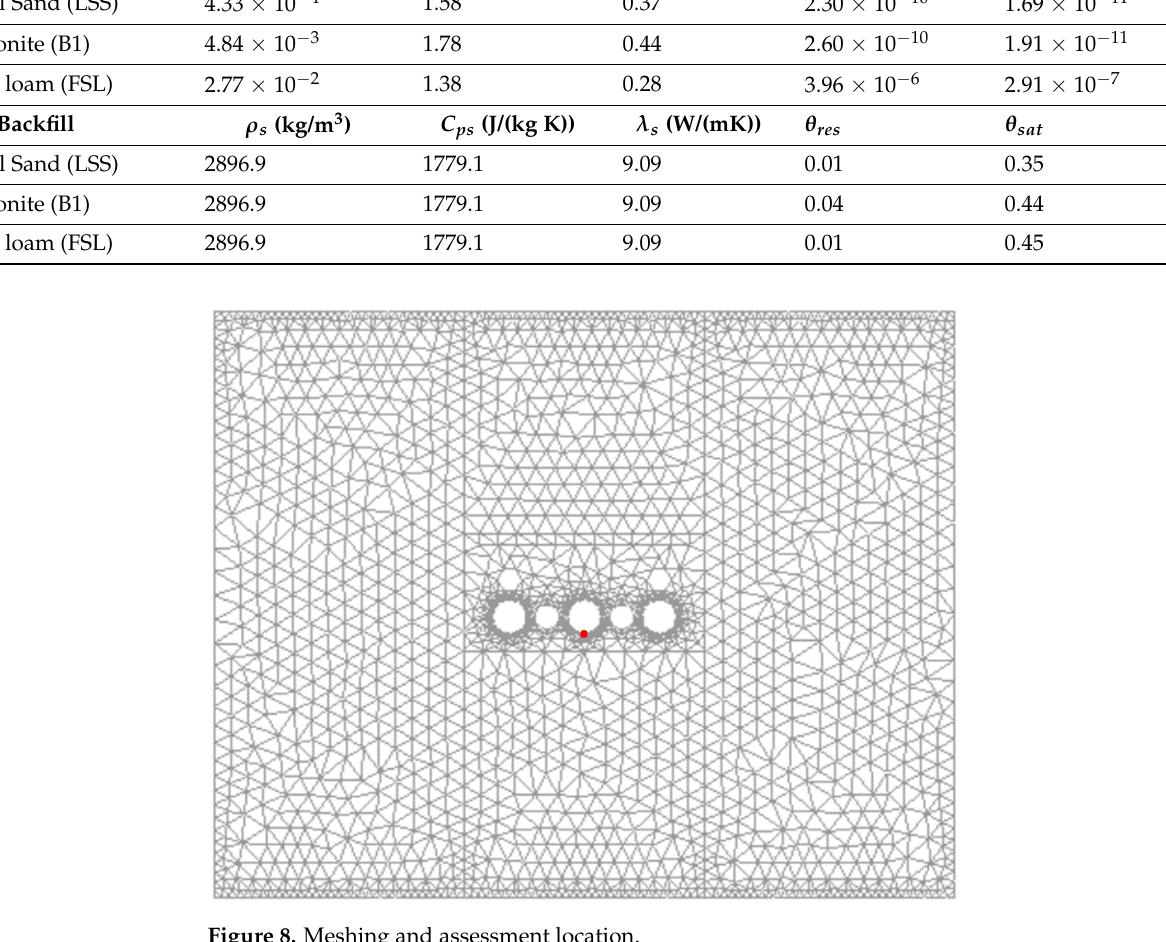
Figure 8. Meshing and assessment